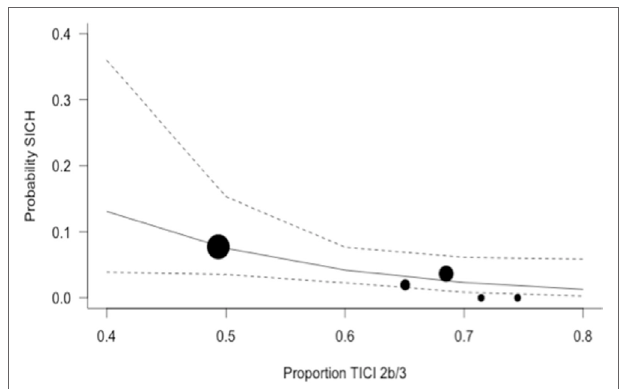
FigUre 4 | Predicted probability of symptomatic intracerebral hemorrhage (SICH) by modified thrombolysis in cerebral ischemia grade 2b/3, with dashed line showing 95% CI, and size of markers inversely proportional to each within-trial SD (intention-to-treat